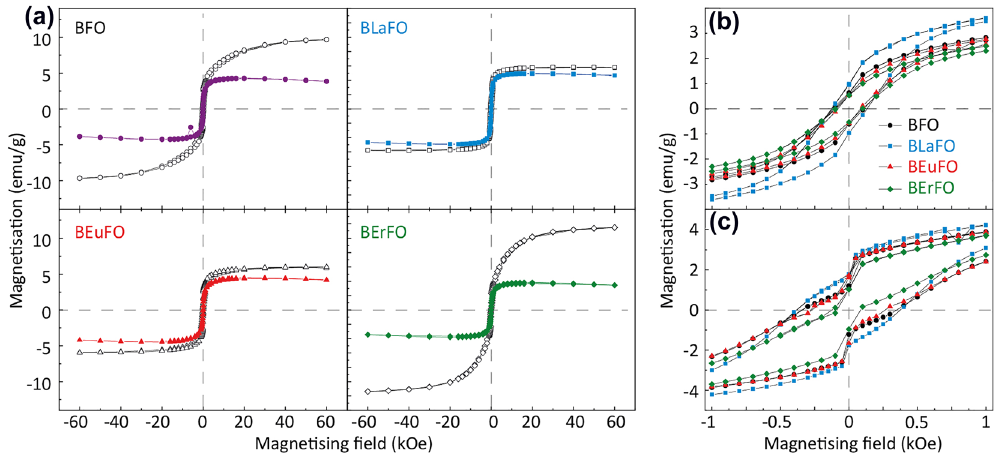
Figure 5. ( a ) M-H curves of neat and doped BFO, measured at 300 K (coloured—filled symbols) and 2 K (black—open symbols), ( b ) enlarged M-H curves of neat and doped BFO measured at 300.0 K and (c) 2.0